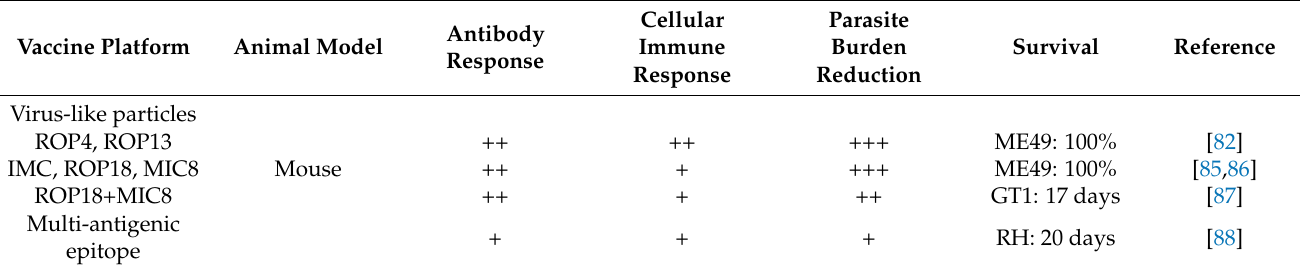
Table 3. An overview of the T. gondii virus-like particle vaccines and their efficacies. Only the studies that assessed all four of the parameters listed below were selected and referenced in the table. Survival refers to the total duration of survival for immunized mice. +, weak; ++ intermediate; +++ strong.